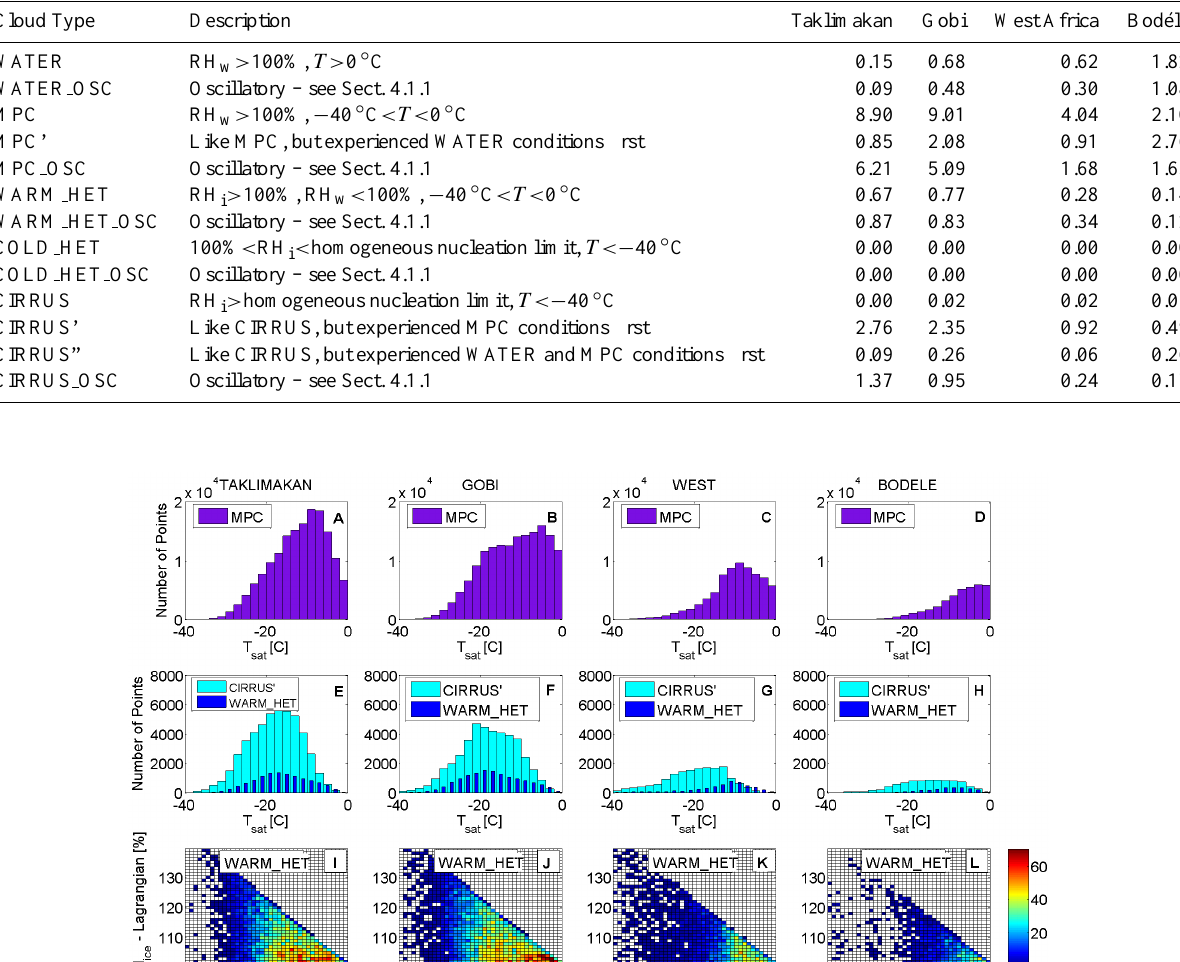
Table 2. Breakdown of cloudy trajectory points in each region (last two lines in Table 1) as a percent fraction of all trajectory points in each region ( ∼ 1.8 × 10 6 ) . (This is Fig. 5, in table form.)